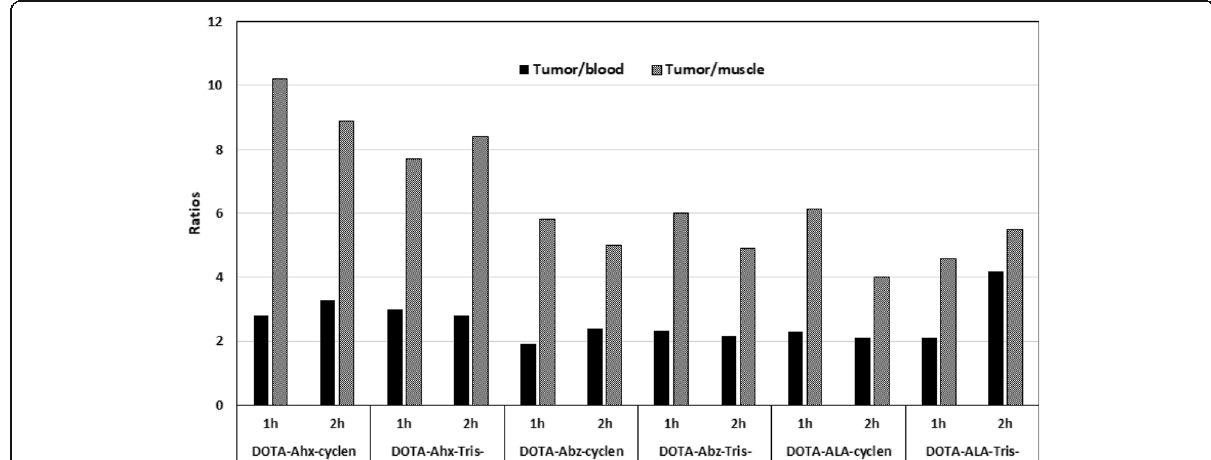
Fig. 6 Tumor-to-blood and tumor-to-muscle uptake ratios for the 68 Ga-DOTA-BN peptides in MDA-MB-231 xenografted nude mice at 1 and 2